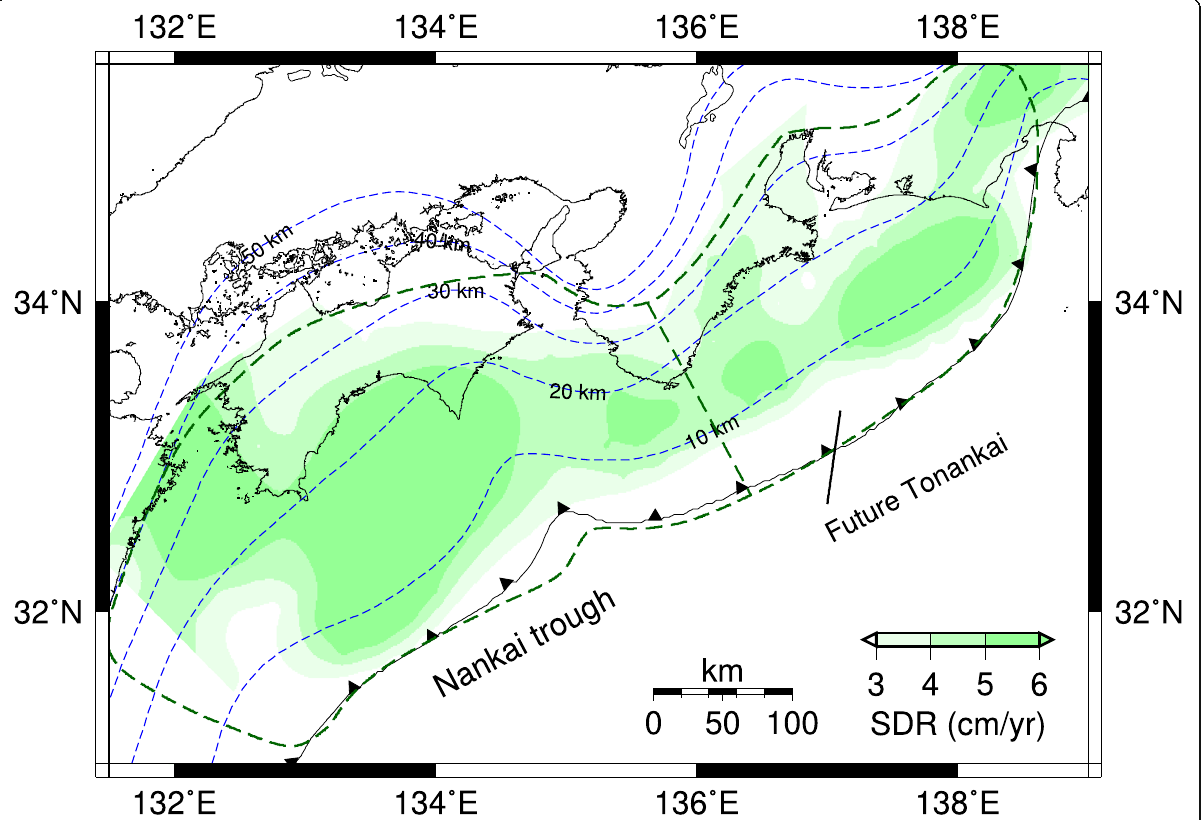
Fig. 1 Geometry of our model of the plate interface along the Nankai trough. Blue dashed contours are depth to the plate interface. Green shading represents the SDR distribution (Yokota et al. 2016). The green dashed lines enclose the source areas of expected future megathrust earthquakes (Earthquake Research Committee, the Headquarters for Earthquake Research Promotion in Japan, 2013). The line with triangular teeth indicates the thrust fault on the plate interface at the trough